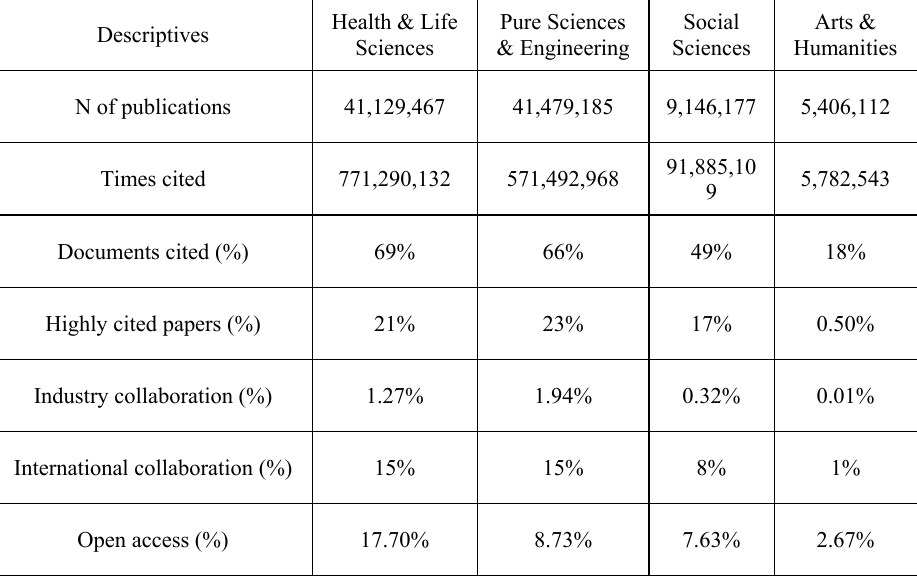
Table 1. Descriptives for the scientific production of the